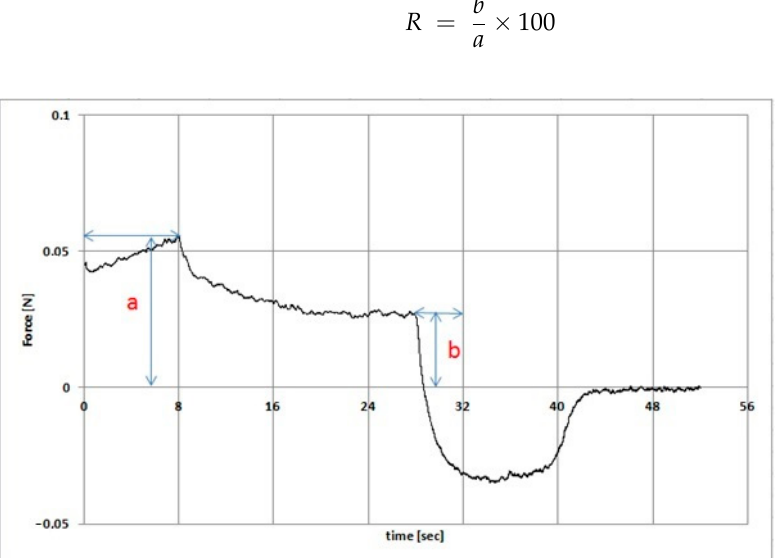
Figure 2. Example of a stress relaxation profile (the symbols are discussed in the text). Parameters a and b were the forces recorded initially and after 20 s of relaxation [33].